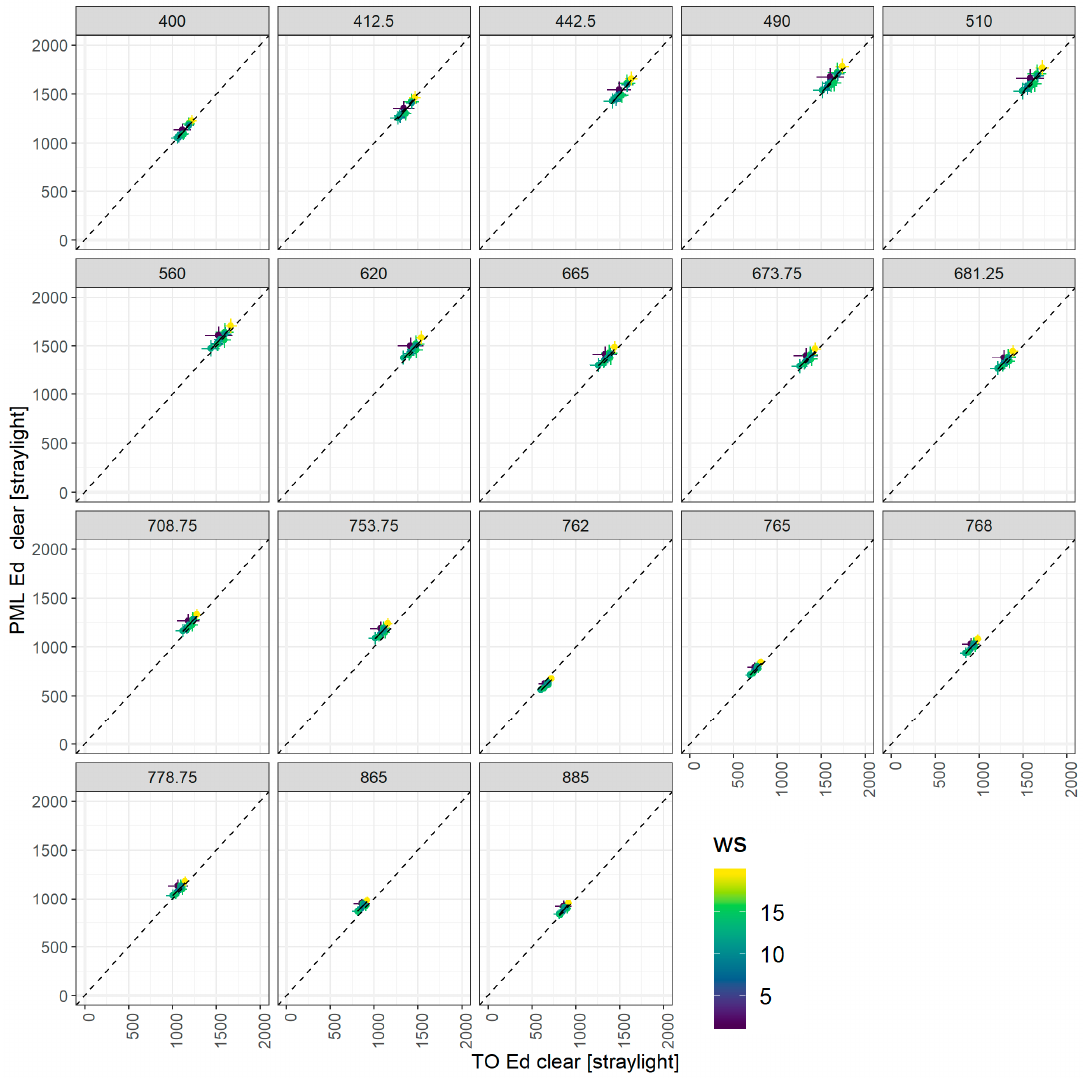
Figure A3. Comparison between TO and PML E d ( λ ) after straylight correction and NIR similarity correction at OLCI’s bands.